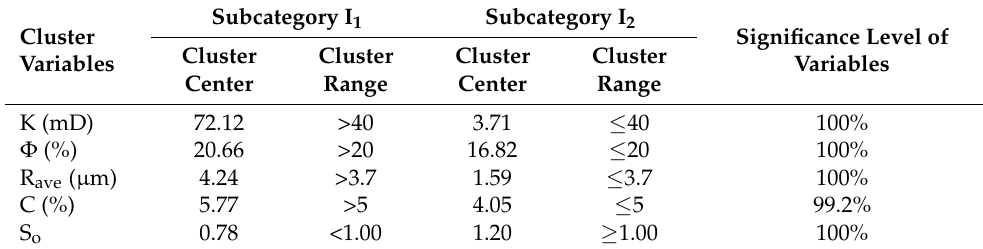
Table 7. Final cluster center and cluster range of subcategories I 1 and I 2 .